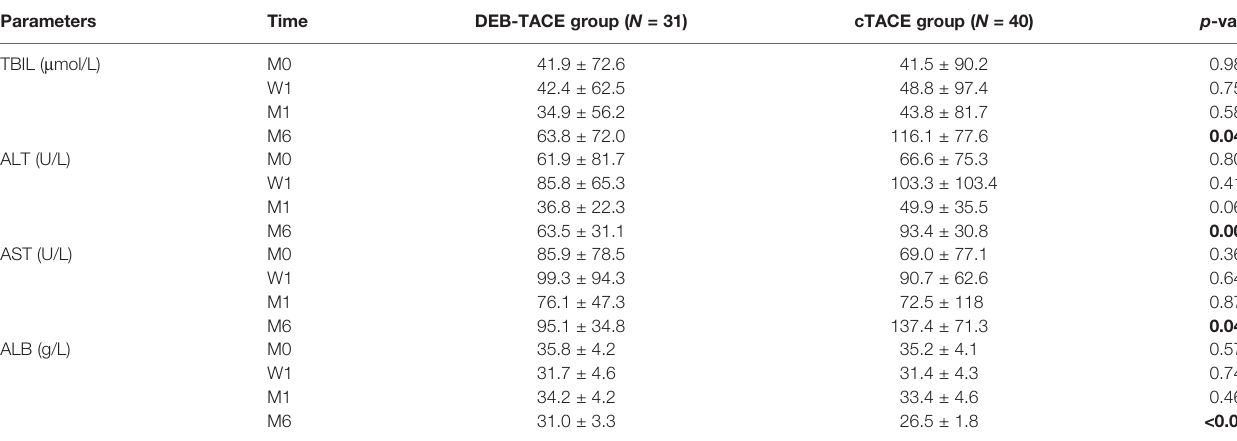
TABLE 4 | Change of liver function before and after treatment.